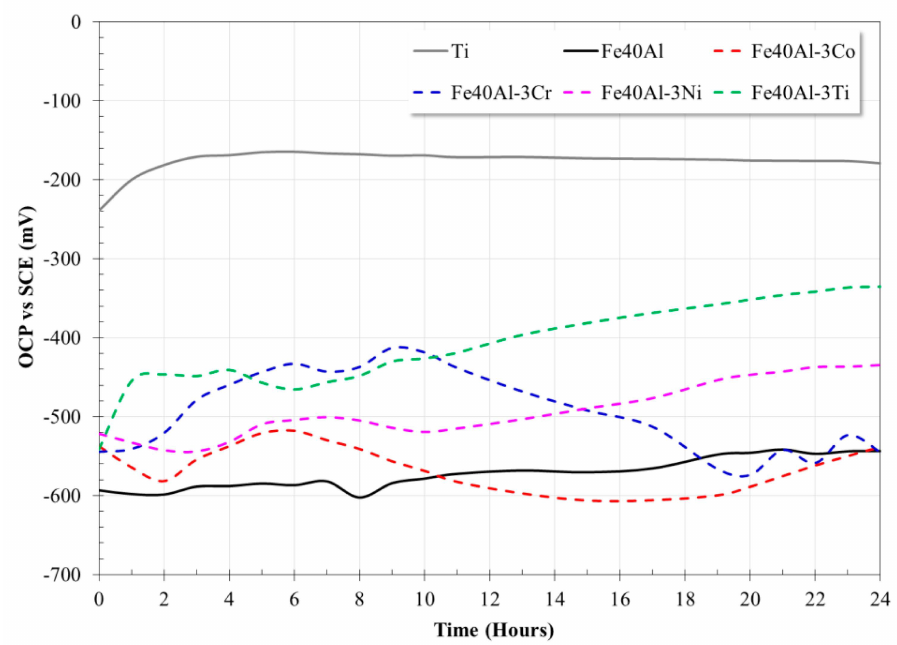
Figure 3. Variation of open circuit potential (OCP) of the evaluated alloys as a function of